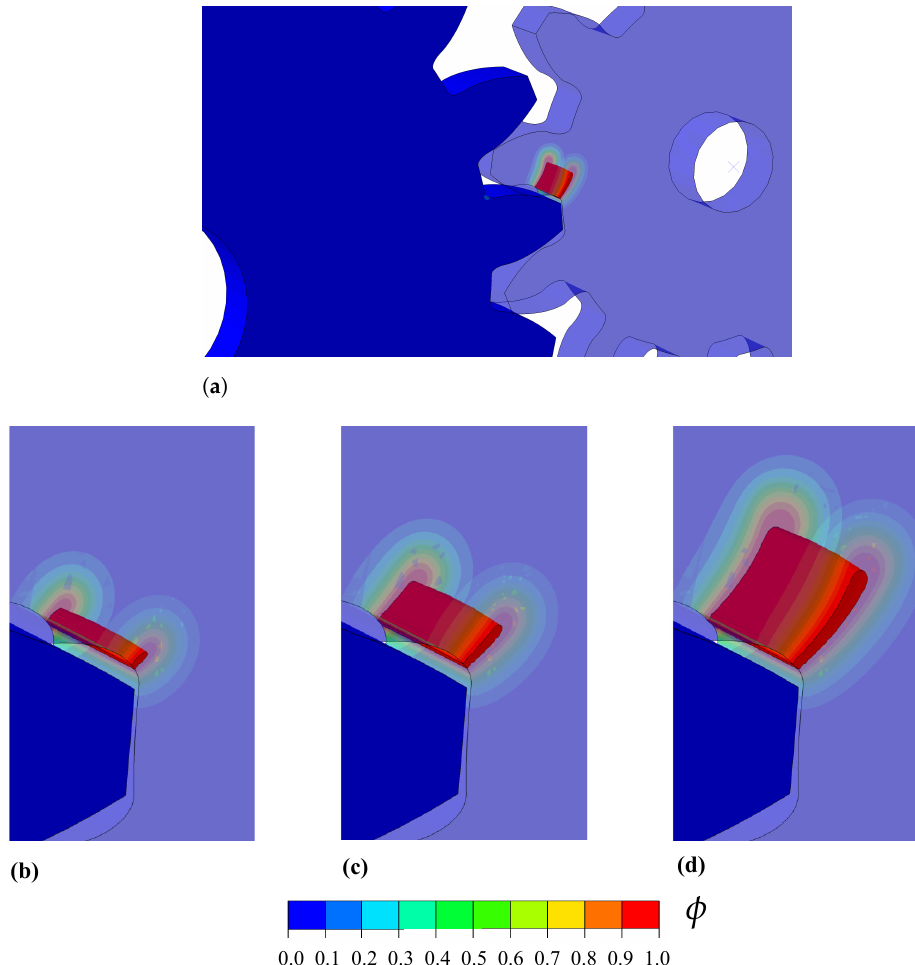
Figure 9. Cracking in interacting gears: phase field contours, ( a ) overall view at an advanced stage of cracking, and detail at ( b ) 0.028 + 2 × 10 − 7 rad, ( c ) 0.028 + 5 × 10 − 7 rad and ( d ) 0.028 + 9 × 10 − 7